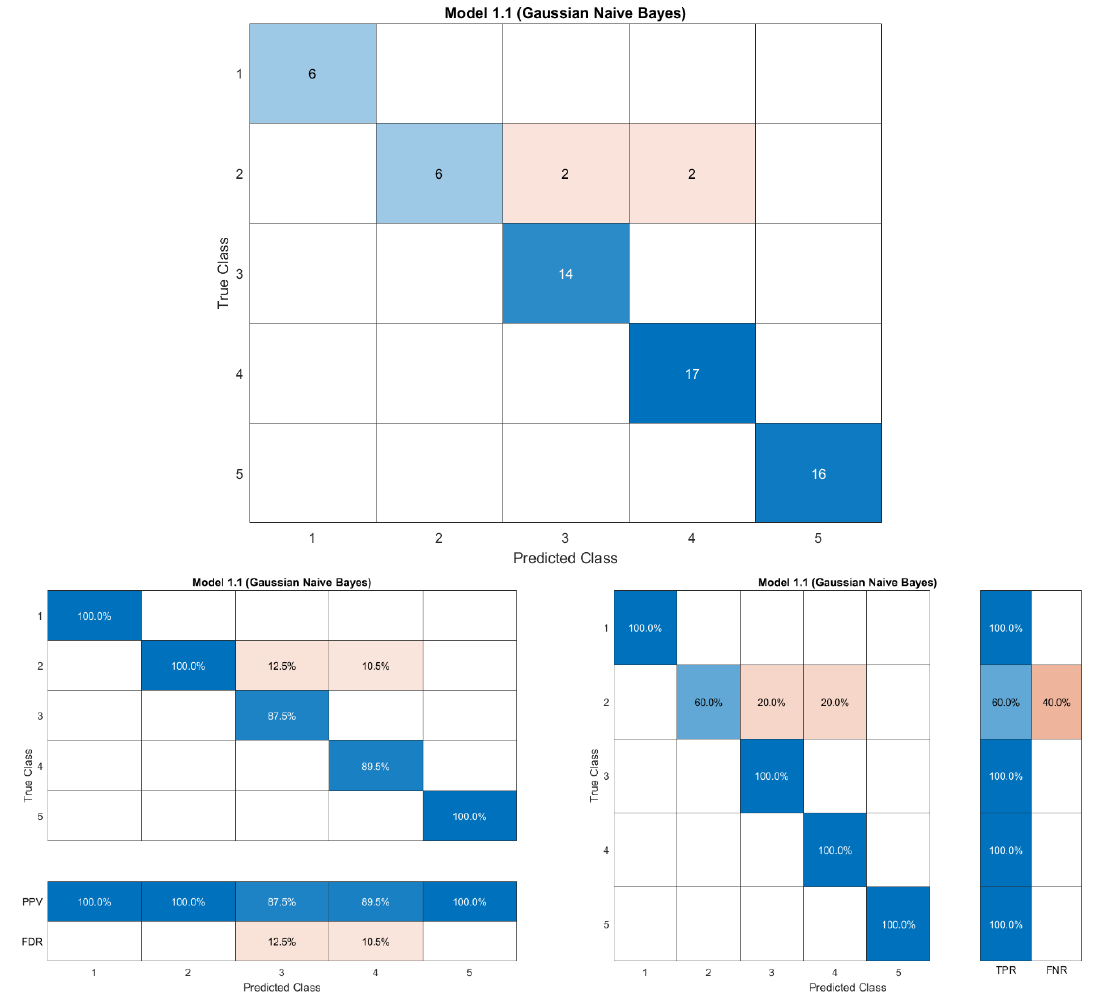
Figure 10. The classification error representation of the Gaussian Naive Bayes classifier, where x points represent the incorrect classification of data.